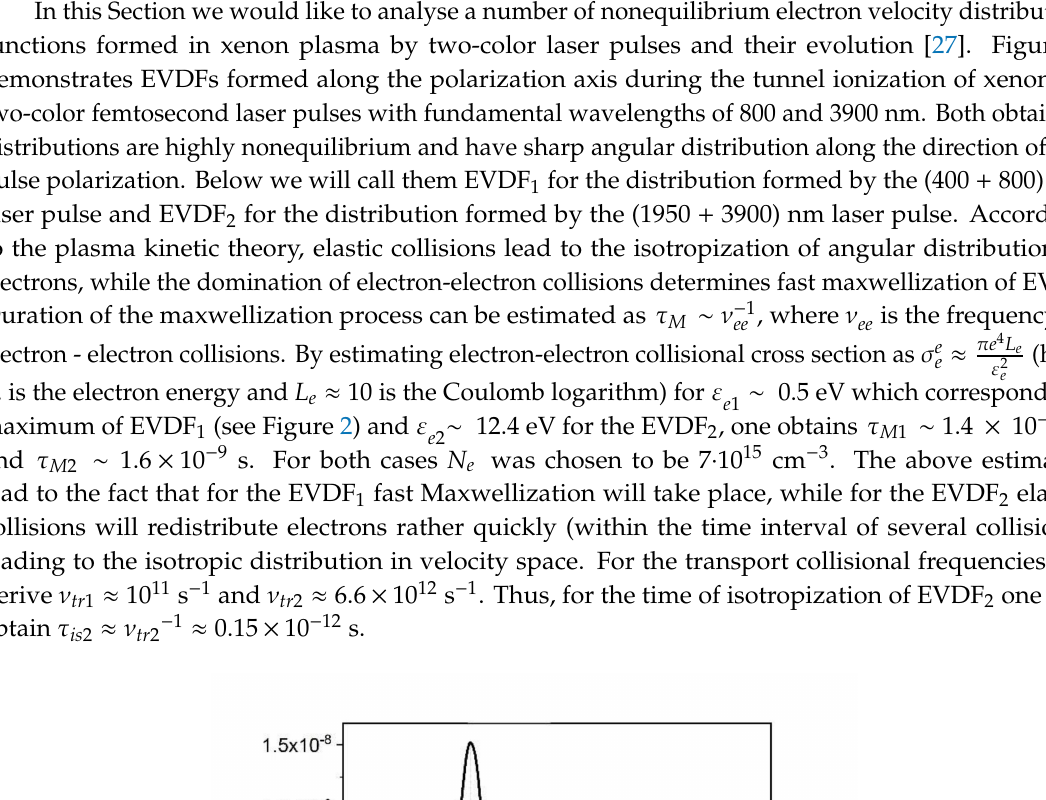
= 2.09 · 10 8 , ∆ ν || = 2.46 · 10 8 cm / s for 0